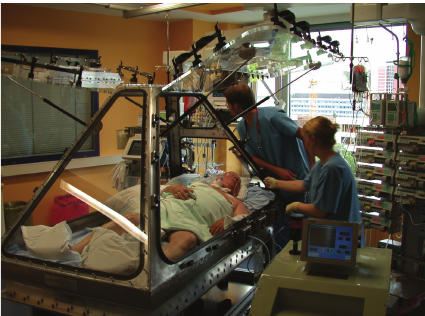
Figure 3: Patient with ARDS in the chamber respirator. CENPV has been discontinued and the chamber opened to enable better access for nursing procedures. The PEEP was elevated before opening the chamber to compensate for discontinuation of end-expiratory neg- ative chamber pressure, and the patient is breathing spontaneously while receiving pressure support from the conventional ventilator. The separate pump unit (bottom right) was manufactured by Coppa S.r.l. (Biella, Italy) and was usually integrated into a tank respirator.